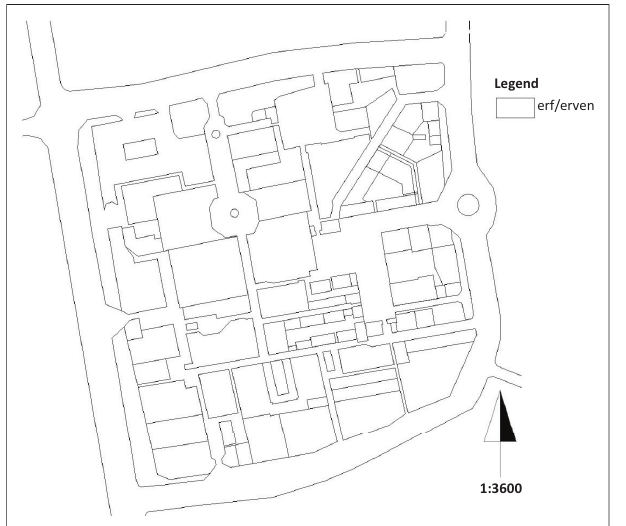
FIGURE 3: Underlying erven structure. FIGURE 4: The built form of buildings in the central business district.